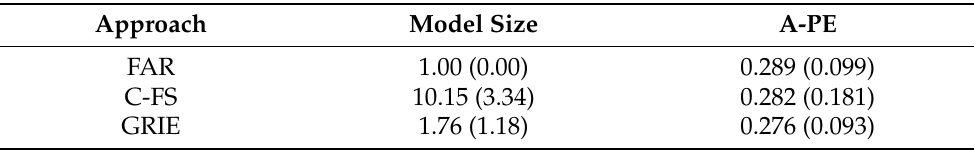
Table 9. Average numbers of model size, A-PE over 100 repetitions, and their robust standard deviations (in parentheses) of Arabidopsis thaliana gene